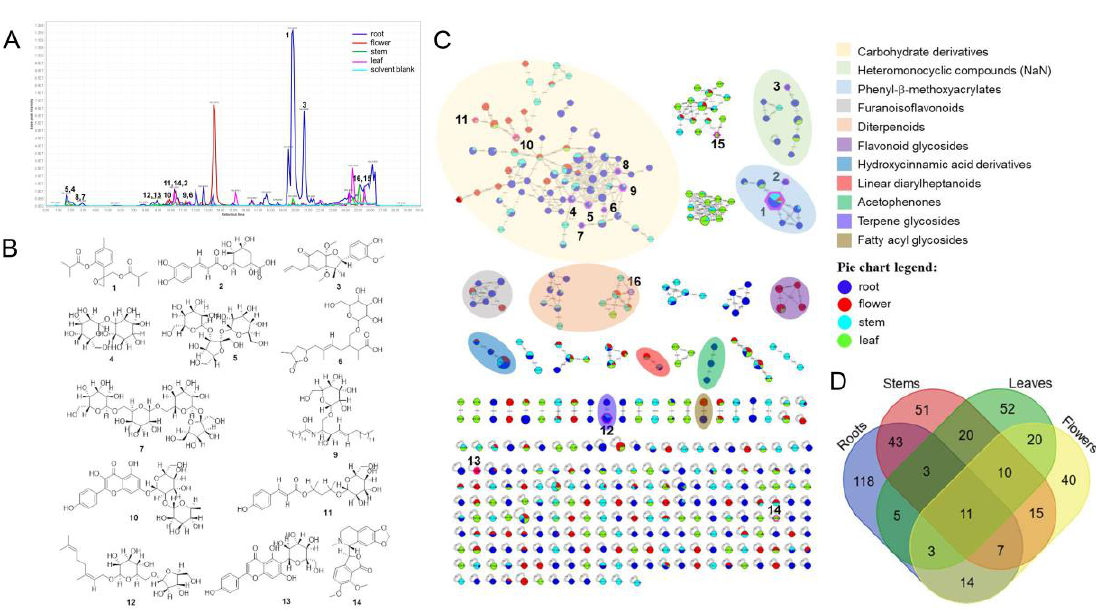
Figure 1. Chemical characterization of secondary metabolites from IEs basing on high performance liquid chromatography-tandem mass spectrometry (HPLC-MS/MS). ( A ) base peak chromatogram (BPC) of representative IE samples in positive mode. ( B ) Several chemical structures of the hits in tolerance against GNPS spectral library. ( C ) The molecular network of IEs [20], in which chemical classification was achieved by MolNetEnhancer at the subclass level, except for the heteromonocyclic compounds classified at the molecular framework level [21] In the molecular network, nodes represent parent ions and their sizes were designed according to the sum of precursor intensity. Nodes from solvent blanks were removed. Pie ratio was determined according to scan number of spectra. Edges represent the degree of similarity between the connected nodes and their thicknesses were corresponding to cosine scores. ( D ) Venn diagram with the precursor ions presented in the molecular network.